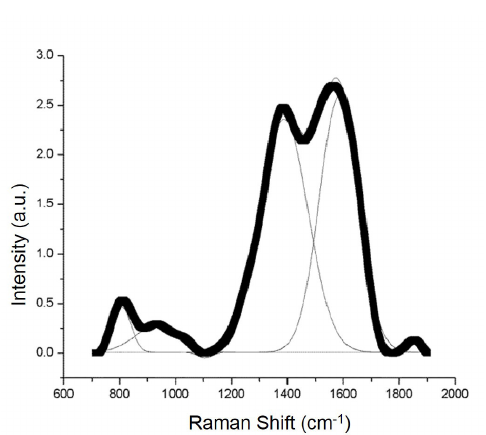
Figure 5. Results from Raman spectrum of the studied DLC